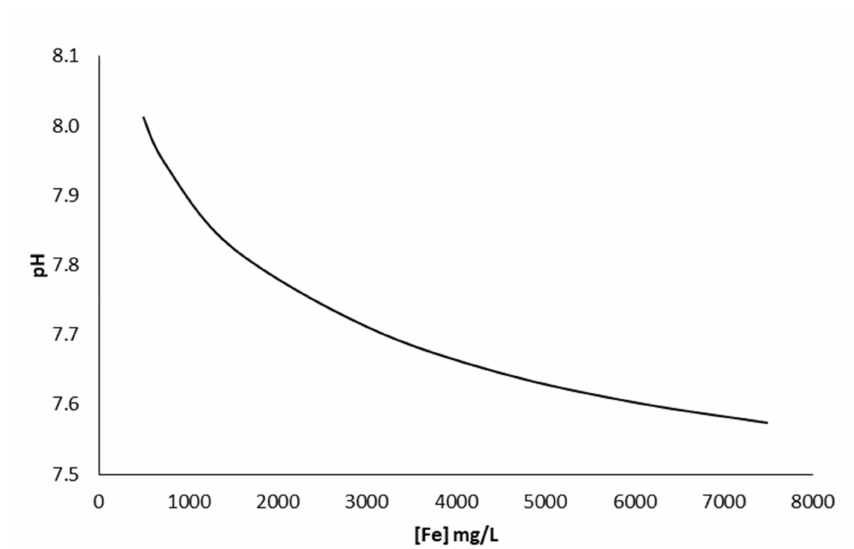
Figure 2. Simulation of equilibrium pH for the precipitation of Fe(OH) 2 as a function of total Fe(II) in solution.